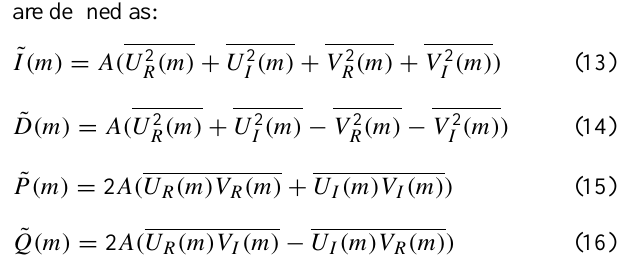
Table 3. Gravity wave parameters estimated from Andenes MF radar